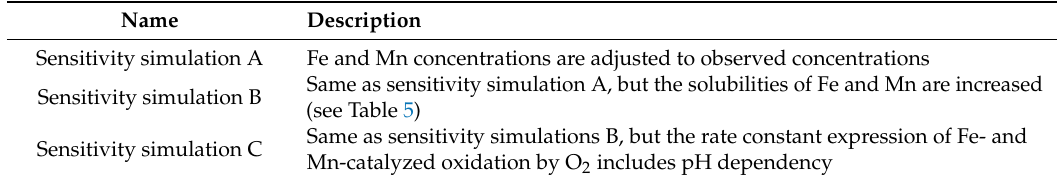
Table 3. A brief summary of the three sensitivity